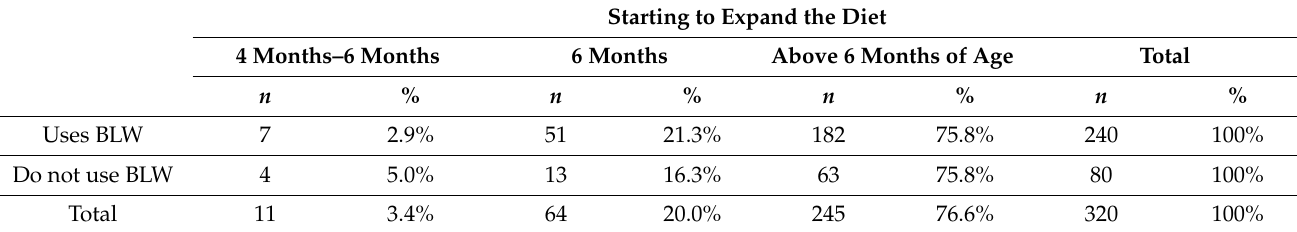
Table 4. Age of initiation of dietary expansion.